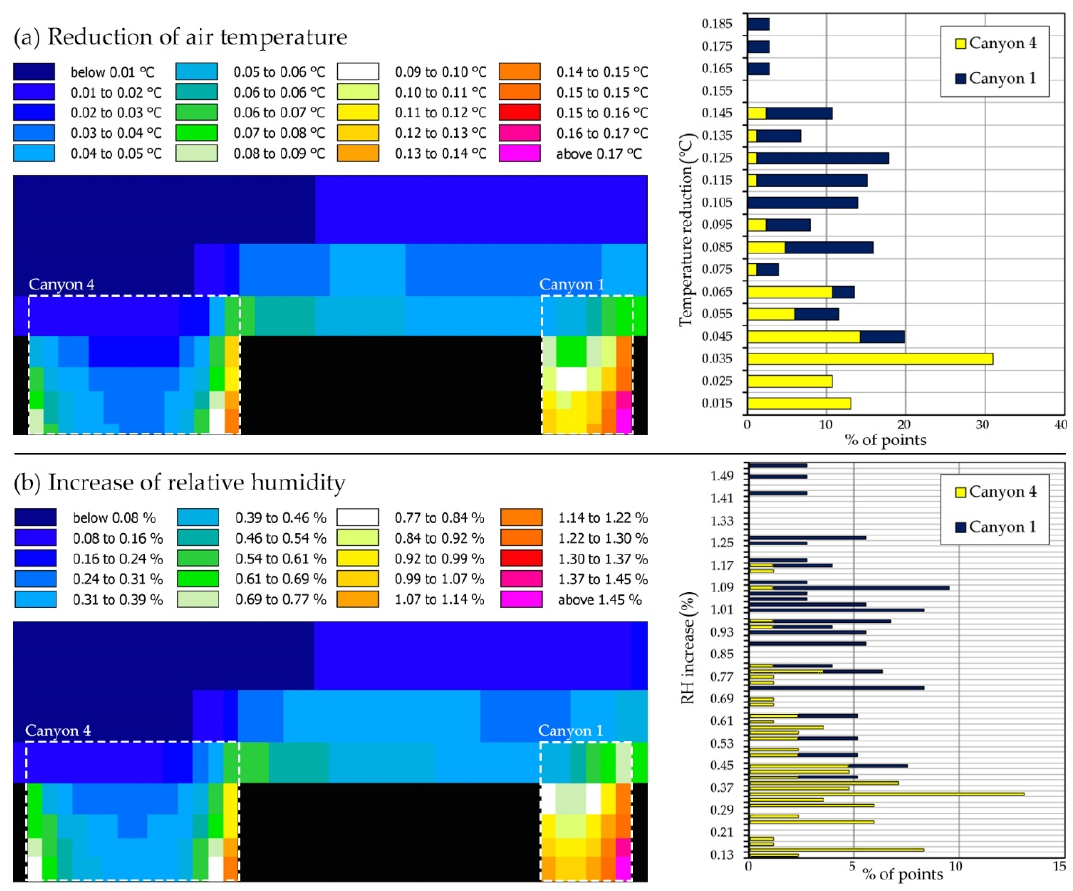
Figure 14. Section AA (Figure 2): external air temperature (°C) ( a ) and relative humidity (%) ( b ) variation recurring to GW.2 solution.